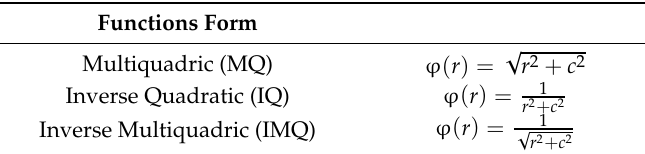
Table 3. Utilized radial basis